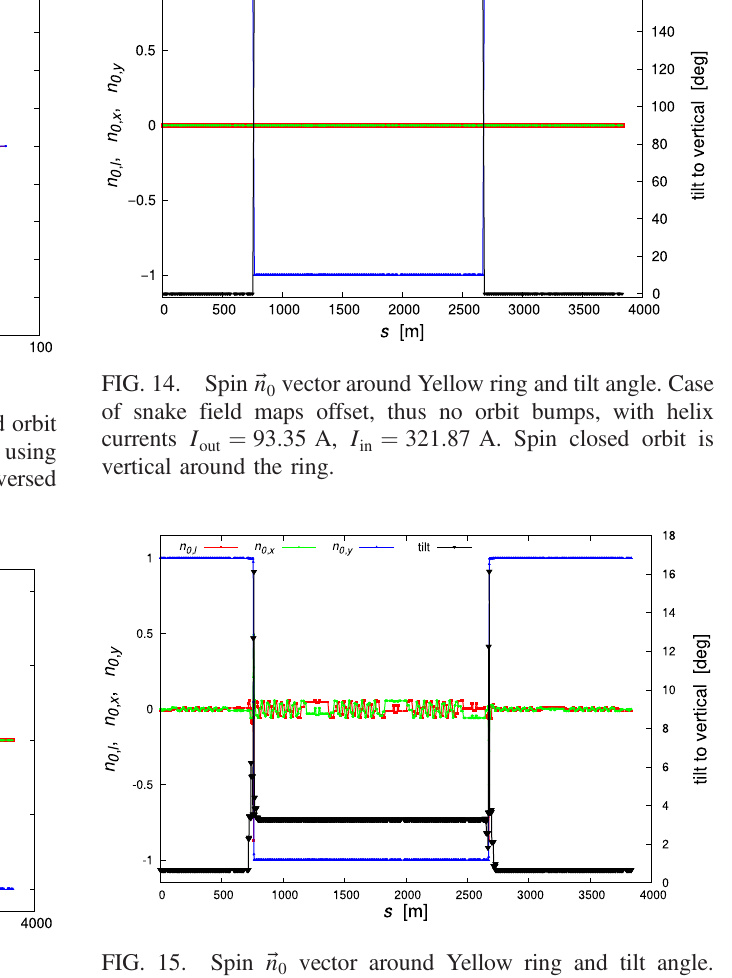
FIG. 13. Spin ⃗ n 0 vector around Yellow ring and tilt angle. No snakes, here, G γ ¼ 45 . 5 . Two trivial cases for reference, both yielding vertical spin closed orbit: on one hand bare, perfect, Yellow ring, flat orbit, and on the other hand, with 90 m extent vertical orbit bumps set in snake regions.